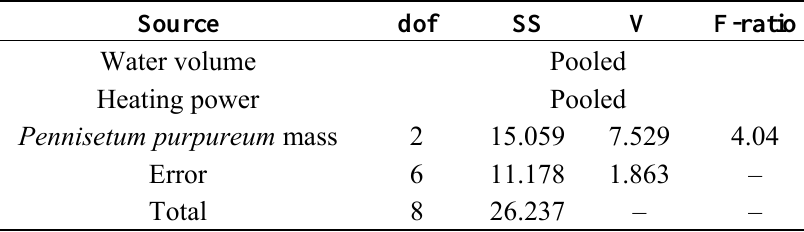
Table 5. ANOVA after pooling of